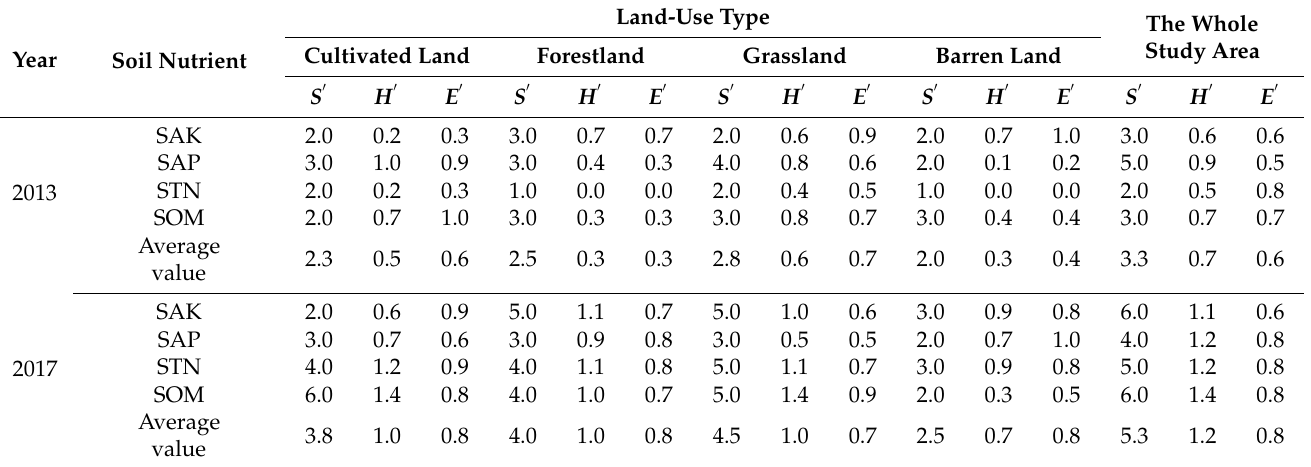
Table 2. Diversity indices of soil nutrient grades under different land-use types.